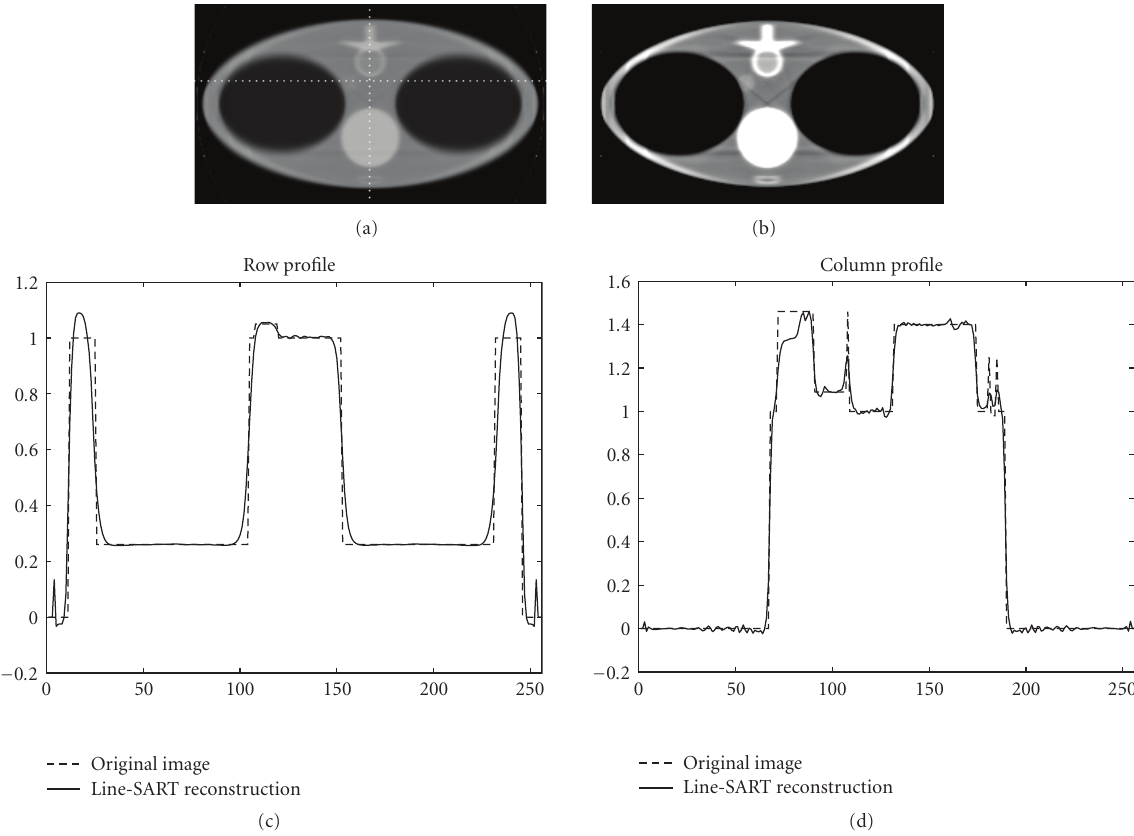
Figure 5: Line SART reconstructed images after 100 iterations using a line source of length 8cm at two di ff erent display windows with profiles along the dotted line. (a) Reconstructed image at a display window of [0,2]. (b) Reconstructed image at a display window of [0 . 8,1 . 2]. (c) Profile of the row. (d) Profile of the